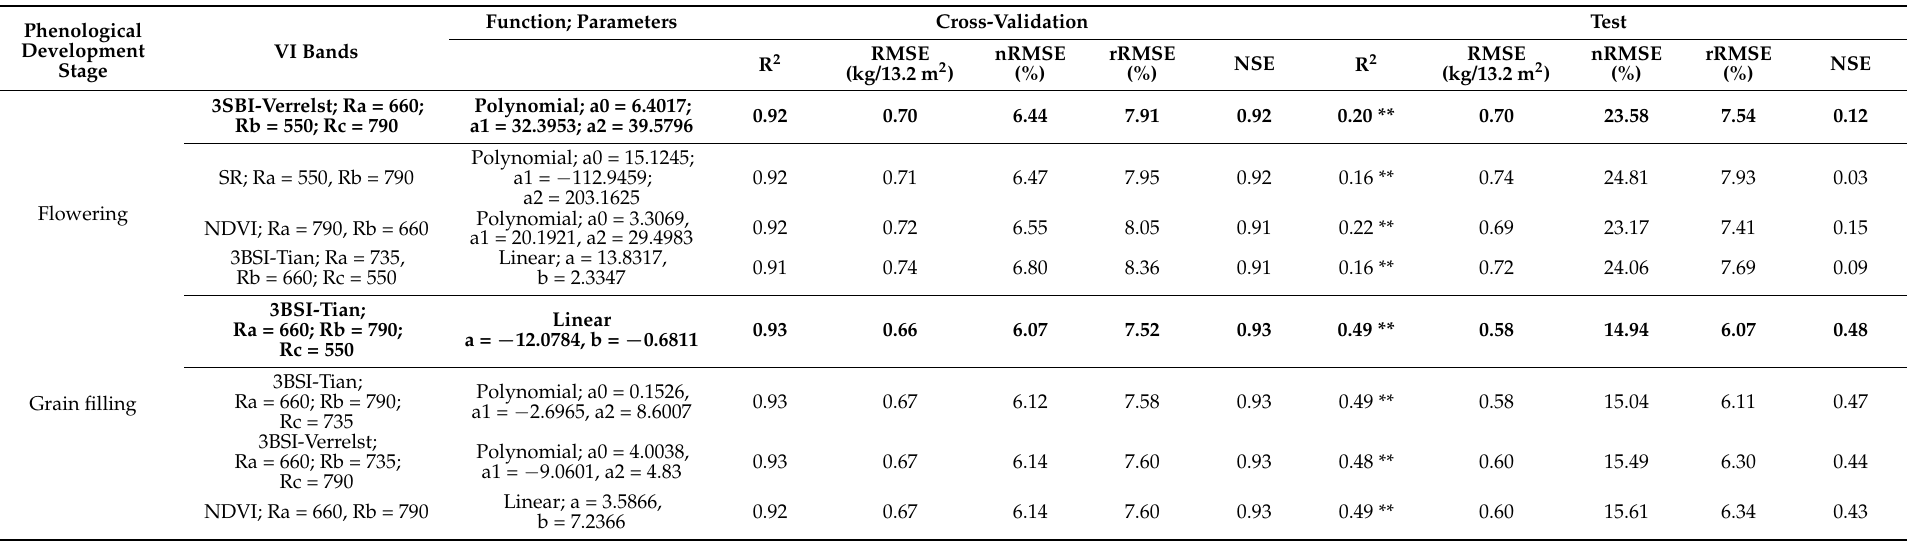
Table 11. Results of GY retrieval with parametric models, n_training = 164, n_test = 55. Levels of significance: ns. not significant; * p < 0.05; ** p < 0.01. The best performing models for each variable are in